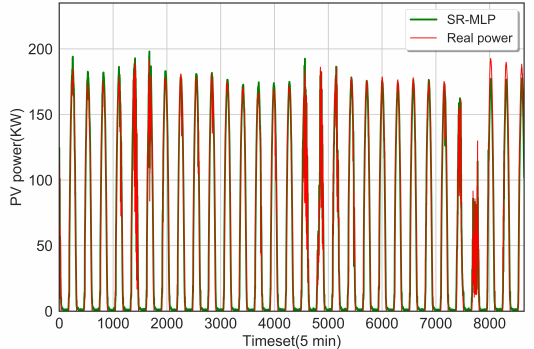
Figure 9. One-month predicted vs. real PV power (kW).